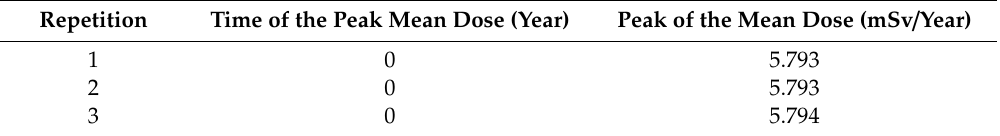
Table 6. Peak of the mean dose derived by probabilistic analysis.